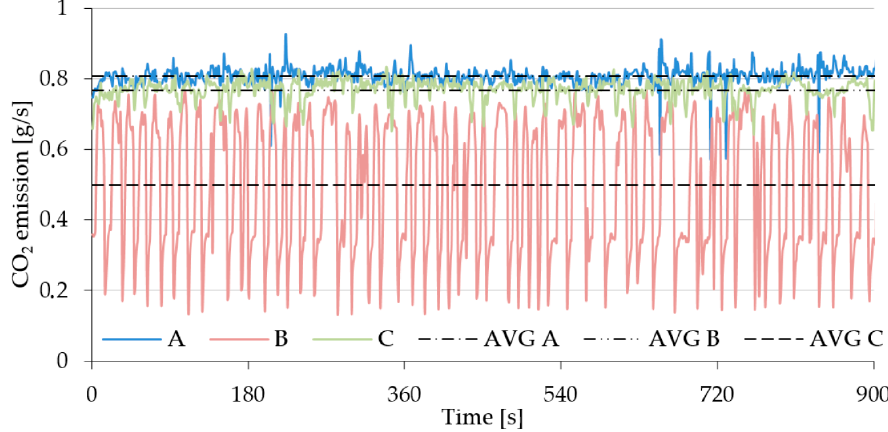
Figure 5. CO 2 emission as a time function during the chipping process: A: Carburettor fuel supply system; B: Injector fuel supply system; C: Injector fuel supply system equipped with an adaptive drive control system.